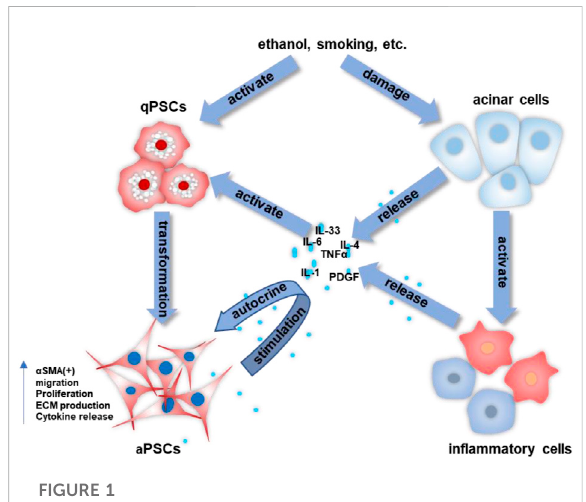
FIGURE 1 The activation process of PSCs in CP. The crosstalk among acinar cells, in fl ammatory cells, and stellate cells allows for the continued activation of PSCs and the progression of pancreatic fi